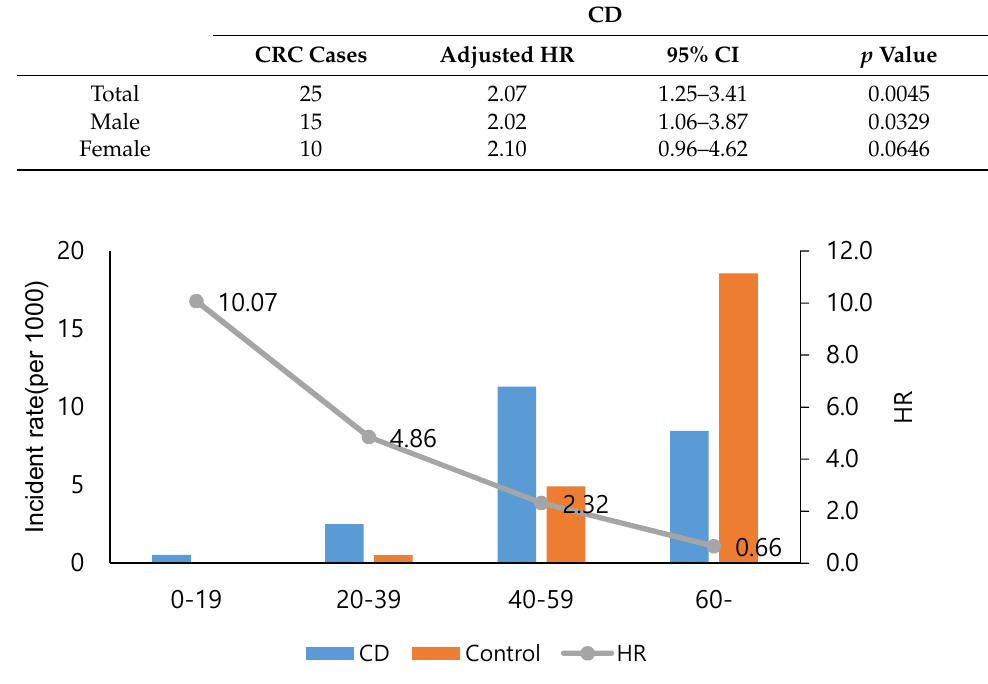
Table 3. Hazard ratio of CD for CRC by sex.